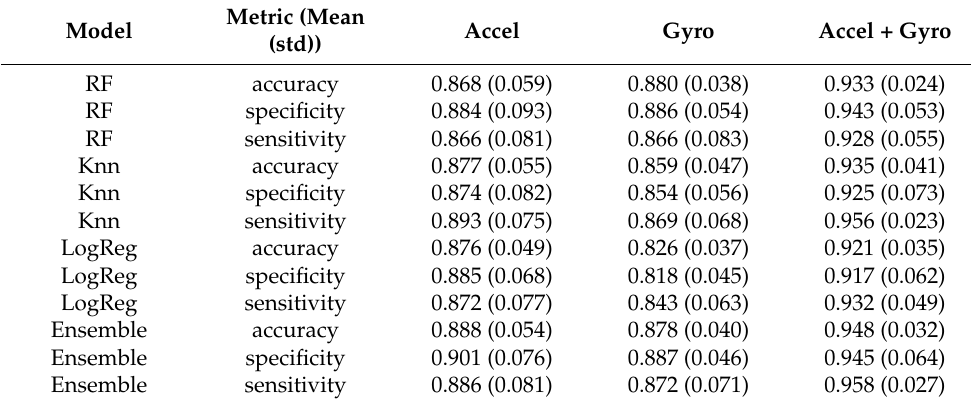
Table 2. Stair climb ascending vs. descending classifier